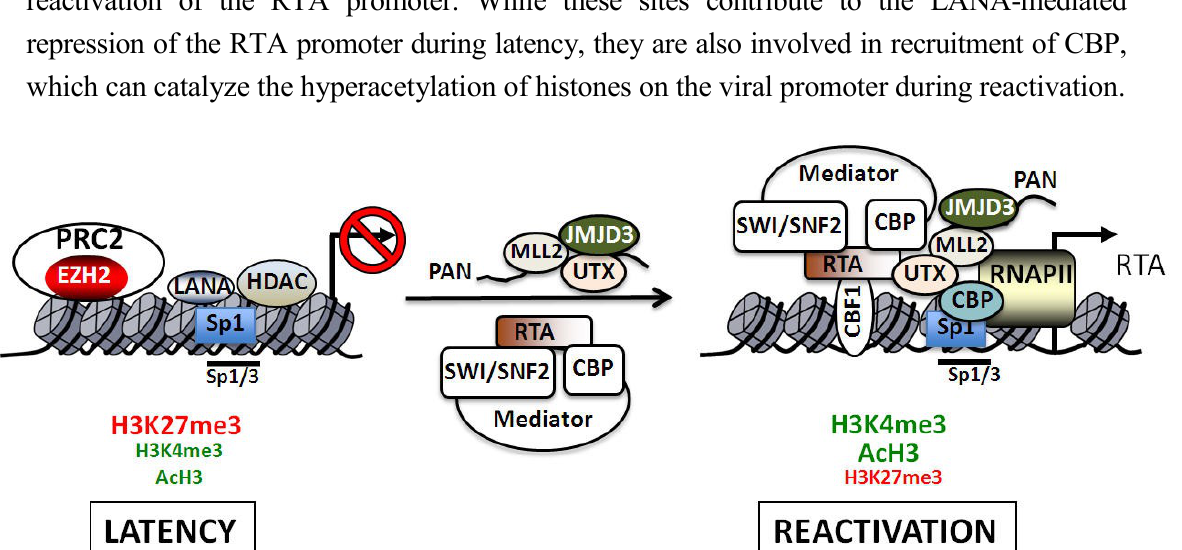
Figure 4. Regulation of the RTA promoter during latency and reactivation. The H3K27me3 histone methyltransferase complex PRC2 as well as specific histone deacetylases (HDAC1, 5 and 7) are critical transcriptional repressors that are present on the RTA promoter during latency. The bivalent chromatin of the RTA promoter is indicated by the presence of both activating (H3K4me3 and acH3) and repressive (H3K27me3) histone marks. After reactivation RTA binds to its own promoter via CBF-1 (also called RBP-Jκ) and recruits several cellular transcription factors such as the Mediator, the ATP-dependent chromatin remodeling complex SWI/SNF2 and the histone acetyltransferase CBP. The induction of transcription is accompanied by the rapid recruitment of RNA polymerase II (RNAPII) and increased binding of Sp1 to the promoter. The KSHV non-coding PAN RNA can also interact with the RTA promoter and recruit the H3K4me3 histone methyltransferase MLL2 as well as the H3K27me3 histone demthylases UTX and